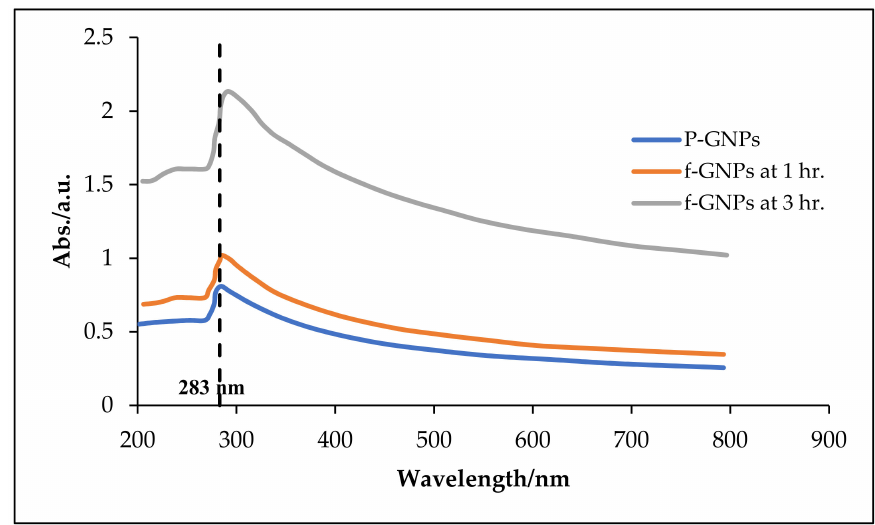
Figure 5. UV–VIS variations for pristine GNPs and f-GNPs at 1 and 3 h sonication periods. Zeta potential is defined as the measure of the effective electrical charge on NPs’ surface. Its magnitude represents particle stability; higher magnitudes mean increased stability from the (more) pronounced electrostatic repulsion between NPs [33,34]. Generally, NPs with zeta potentials of ≥ 30 mV or ≤ 30 mV are expected to be stable for the long term. Dispersions with zeta potentials of ≤ 25 mV or ≥ 25 mV will agglomerate due to interparticle (secondary) interactions [35]. The stability of the f-GNP suspensions in distilled water was elucidated using its zeta potential values and size distributions (Figures 6 and 7). Figure 6 shows the zeta potential and polydispersity index (PDI) of the f-GNPs at a pH value of 7. Both factors are representative of the nature of the electrostatic interactions between the colloidal NPs and can be indicative of the state of stability of the overall solution(s). A more negatively charged ( − 39.4 mV) solution was reported postsonication for 1 h with the f-GNPs at a temperature of 25 ◦ C. The size distributions of the f-GNPs solutions were determined using the concept of dynamic light scattering (DLS), and the results are shown in Figure 7, where the average particle size of the f-GNPs was 442 nm. The size distribution of the f-GNPs was 83.9–1318.6 nm, and its PDI was 0.255 (low).